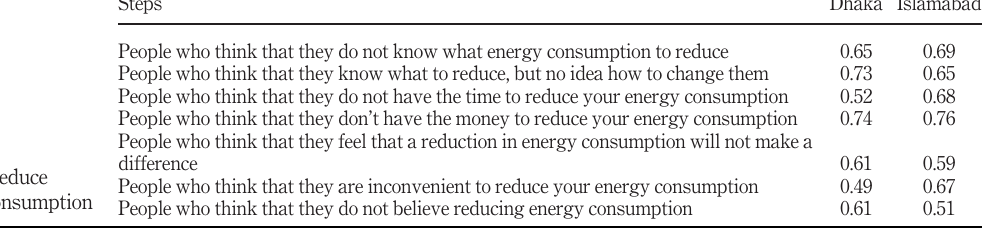
energy consumption